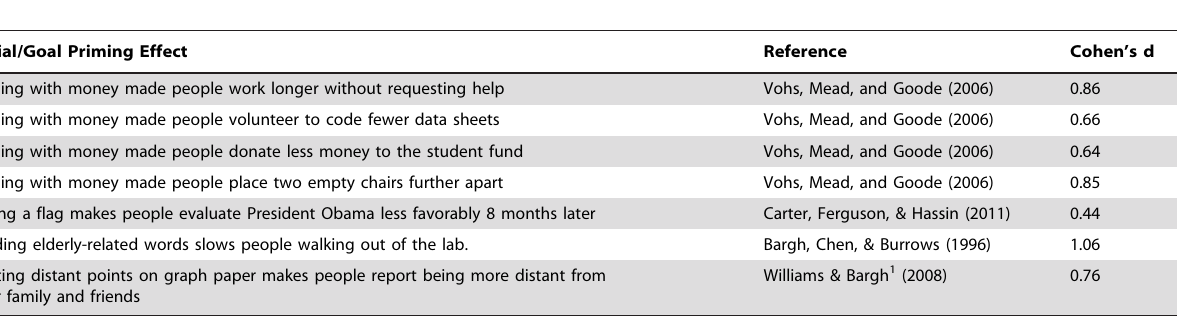
Table 1. Effect sizes (Cohen’s d) for a small number of well-known social and goal priming effects reported in the literature.